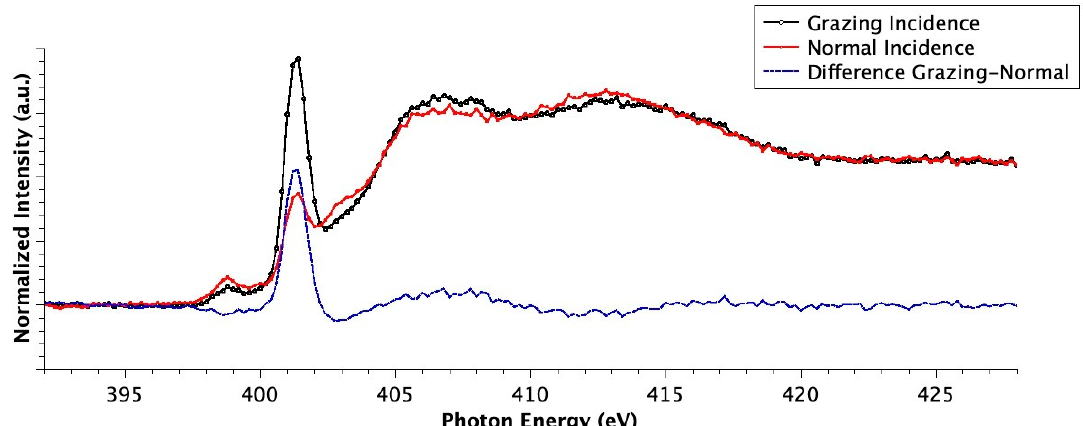
Figure 6. Angular dependent N K-edge NEXAFS spectra collected at Normal (90°, red line) and Grazing (20°, black line) incidence angles of the impinging X-ray beam on Ti-HAP after incubation with SAP solution at pH = 4. The difference (Grazing–Normal) spectrum, evidencing dichroic effects, is also shown (blue line).